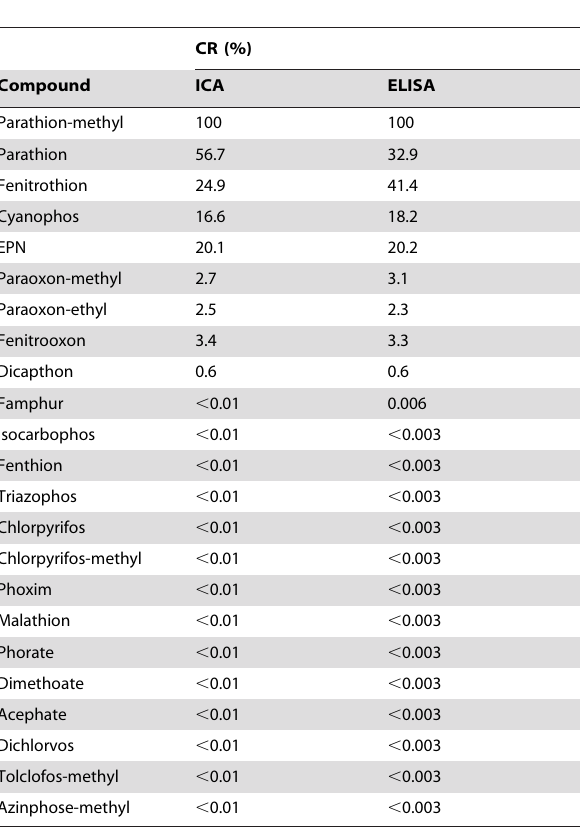
analyte, the T line will exhibited a similar color to the C line, which indicated that the test result was negative. The test was ineffective if no line was observed in the control line region (Figure 2).